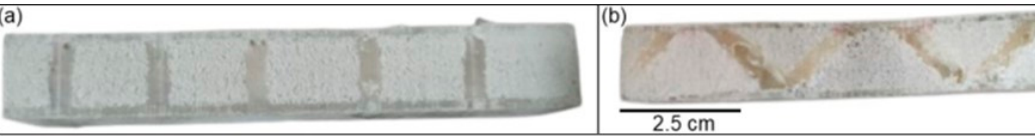
Figure 9. Numerical and experimental flexural load vs. displacement curves for ( a ) R, ( b ) 0HD, ( c ) AHD, ( d ) 0OPT and ( e ) AOPT designs. The EXP_X curves are referenced as the experimental curve for each sample (three for each SP configuration). The AOPT design presents the highest difference in flexural stiffness between nu- merical model and experimental results, when compared with other designs. This differ- ence may be attributed to the difficulty the model experienced in predicting the defor- mation field in the indentation region. The core indentation is well defined for this design which is closed of the indenter for 3-point bending test, as shown in Figure 7, while in numerical model this effect is not captured by the crushable foam model. Another factor that may cause this difference is associated with the difficulty of manufacturing the in- clined pins, since the difference in stiffness is also identified in the 0OPT design. Further- more, it is important to mention that failure models are not implemented in the simula-